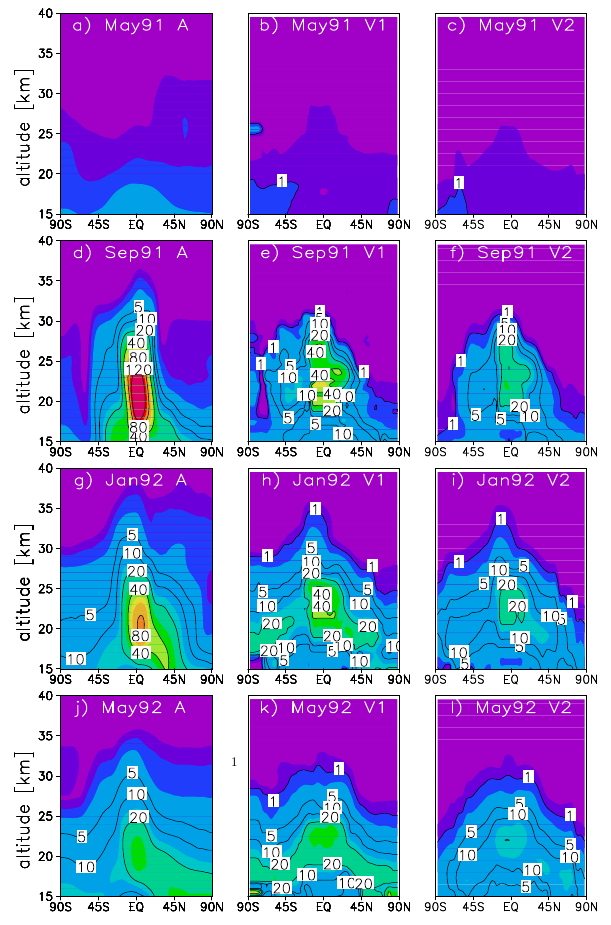
Figure 7. Comparison between zonal mean modelled (run A_Control20) and satellite-derived V1 and V2 SAD (µm 2 cm − 3 ) from SPARC (2006) and Arfeuille et al. (2013), respectively, for various months before and after the